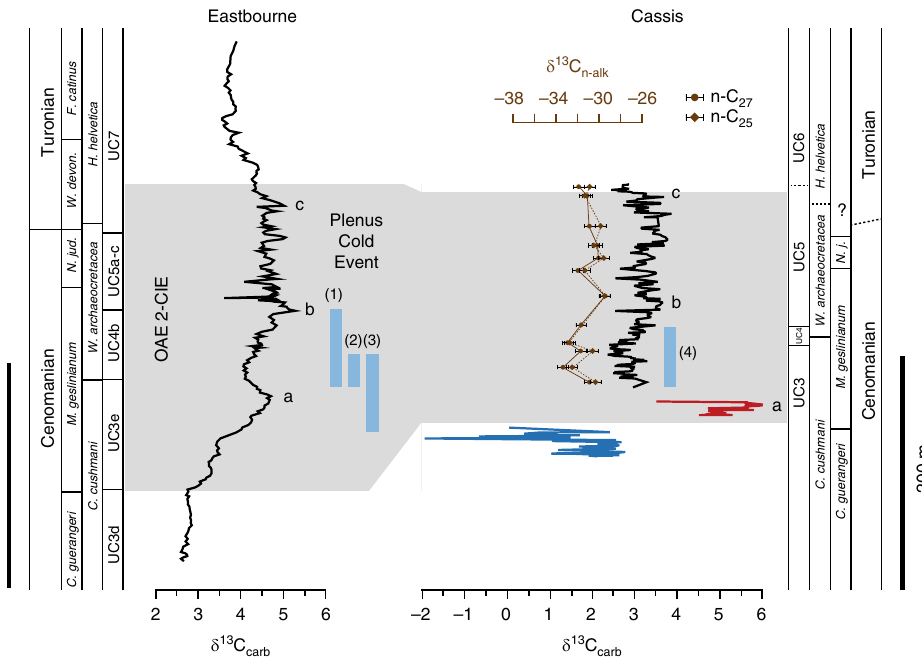
Fig. 2 Bio- and chemostratigraphic correlation. Carbon isotope trend from Cassis, S ’ France is compared with the European reference section at Eastbourne, Sussex, UK 23,24 . Calcareous nannofossil zonation of Eastbourne after ref. 56 . Planktic foraminiferal biozonation of Eastbourne after ref. 69 . Lowercase letters correspond to principal carbon-isotope peaks identi fi ed in the Eastbourne record 24 . Stratigraphic positions of the Plenus Cold Event (PCE) according to (1) 53 , (2) 70 , (3) 13 with (4) representing supposed PCE position at Cassis. Color-code of the Cassis carbon-isotope record corresponds to lithostratigraphic formations 22,28 with blue = Grès de l ’ Anse Sainte Magdeleine Fm., orange = Calcaires du Corton Fm., black = Marnes de l ’ Anse de l ’ Arène Fm. Carbon- isotope stratigraphic trend of plant-derived leaf-wax n -alkanes ( n -C 25 ; n -C 27 ) is restricted to the Marnes de l ’ Anse de l ’ Arène Fm. δ 13 C values of individual n -alkanes are the means of duplicate runs ( σ = ±0.5 ‰ ) expressed versus VPDB. Gray area represents the stratigraphic interval covered by the OAE2 carbon isotope excursion 24,54 . Note the expanded thickness of the OAE2 in the Cassis